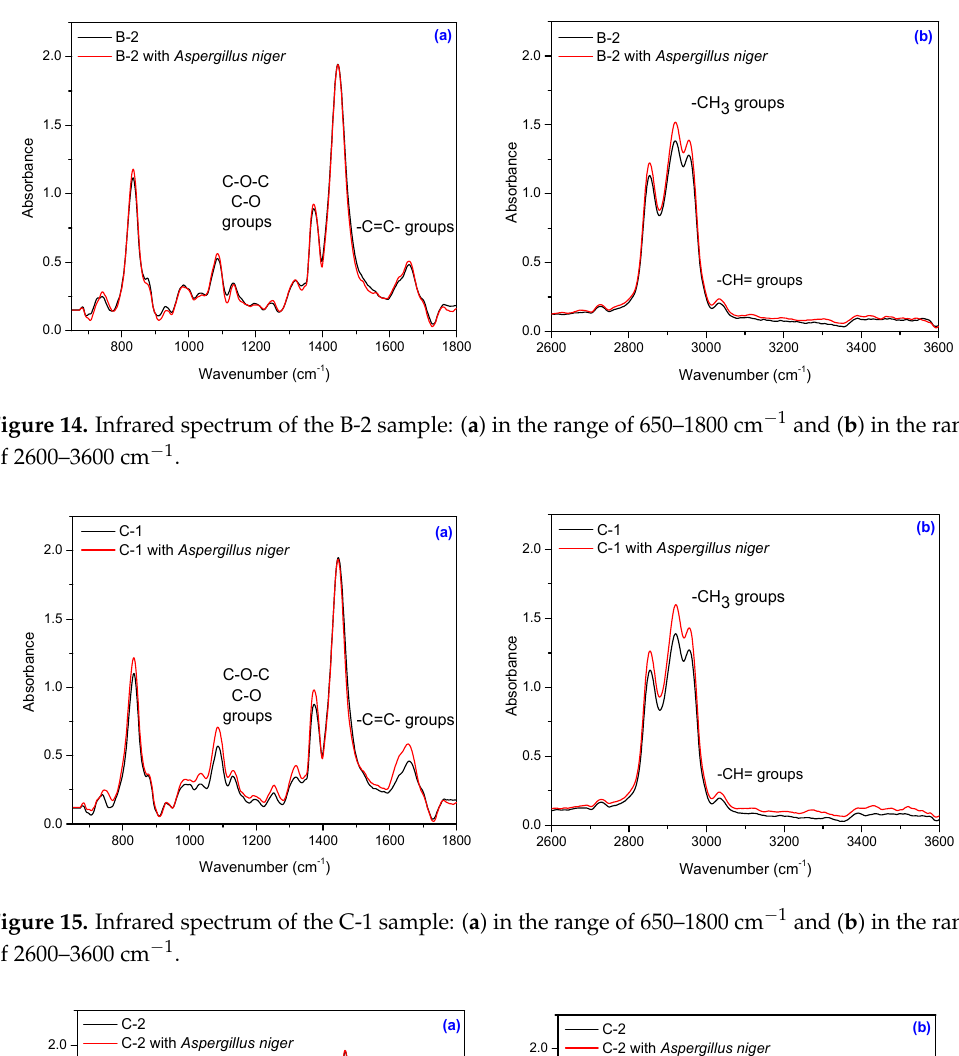
Figure 13. Infrared spectrum of the B-1 sample: ( a ) in the range of 650–1800 cm − 1 and ( b ) in the range of 2600–3600 cm − 1 .